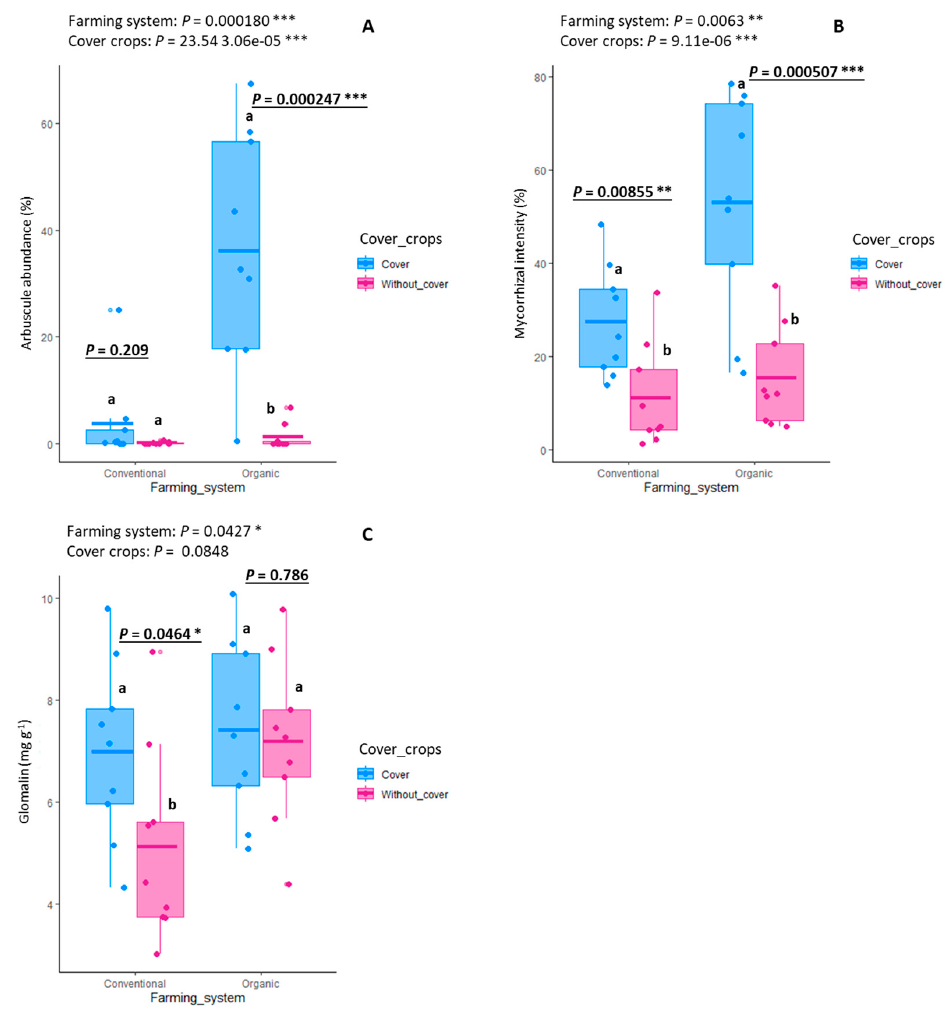
Figure 3. Effect of cover crops on arbuscule abundance ( A ) and mycorrhizal intensity ( B ) of walnut roots and glomalin content ( C ) in soil from the two farming systems (conventional and organic). The boxplot with p-values represents means of each modality using ANOVA ( n = 36). Means followed by the same letter do not differ significantly under the Tukey test at the 0.05 level; significant levels: * p < 0.05; ** p < 0.01; *** p < 0.001.